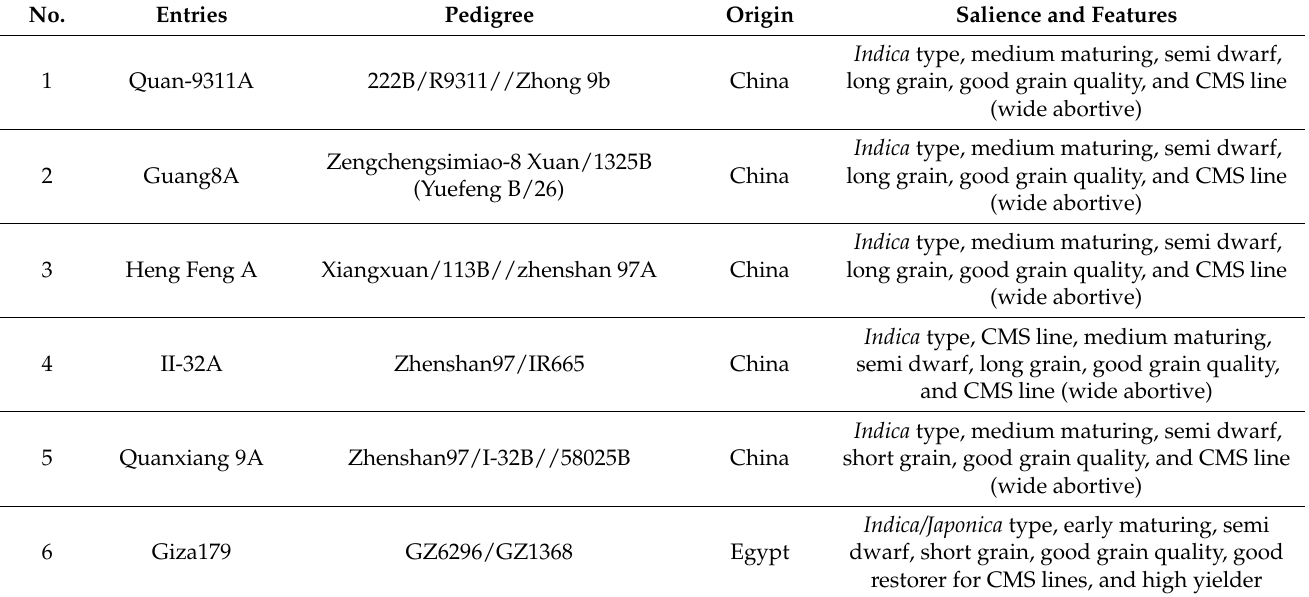
Table 7. Origin, pedigree, aalience, and features of nine parental lines of hybrid